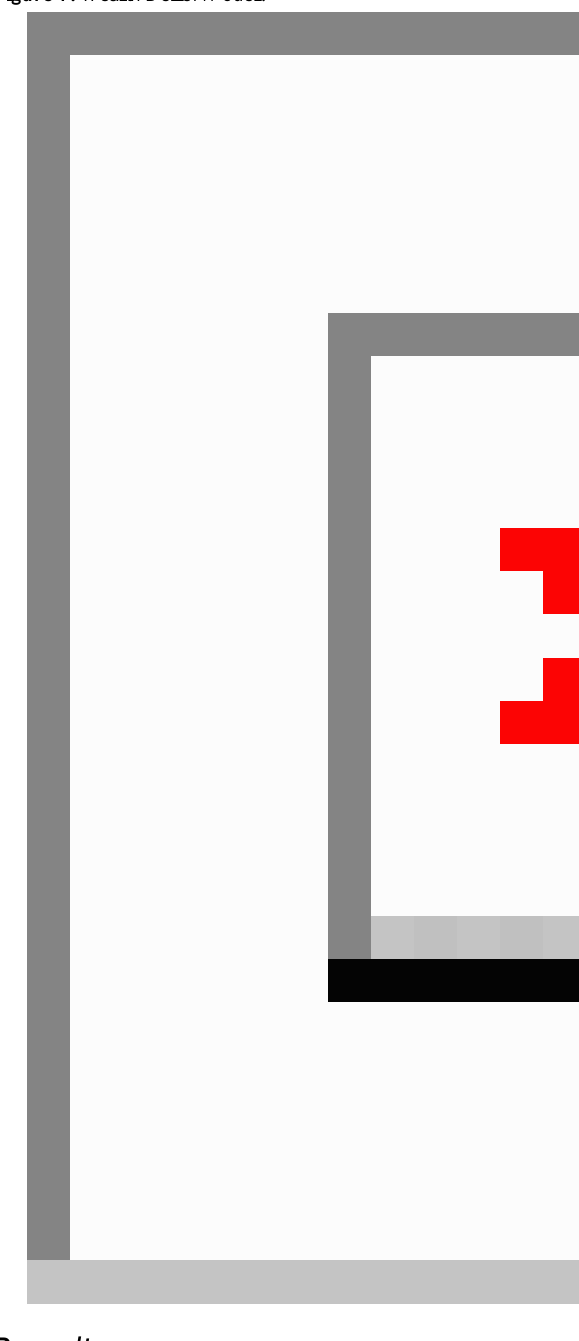
Figure 1. Health Belief